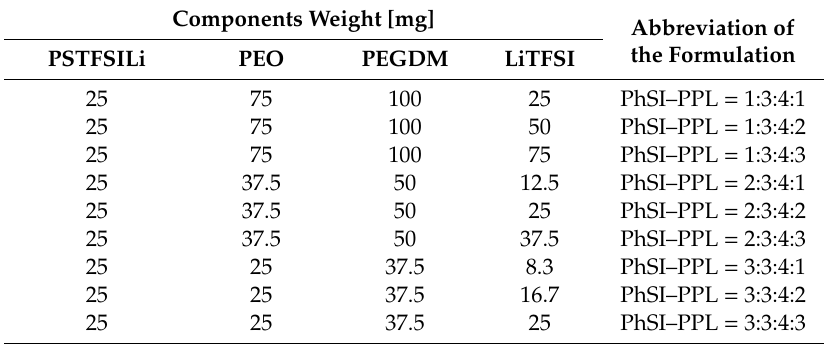
the FormulationPSTFSILi PEO